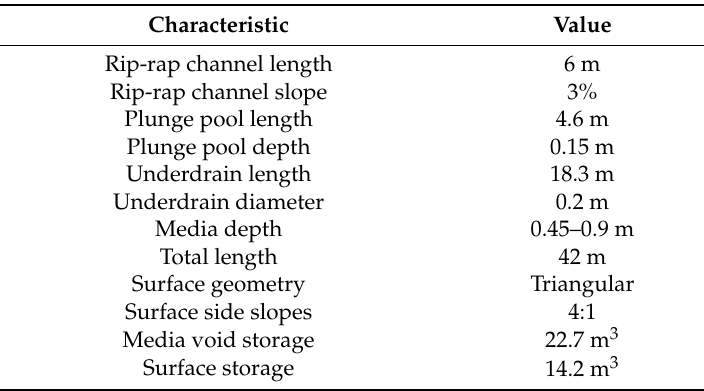
Figure 3. Full structure longitudinal cross-section. Note: not to scale. Table 2. Bioswale design characteristics.